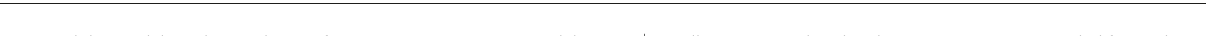
Fig. 3 DOT1L inhibition delays the incidence of GVHD in a xenogeneic model. a CD3 + T cells were stimulated with aAPC/mOKT3, expanded for 12 days in the presence of 0.5 μ M SGC0946 or DMSO, and subsequently infused into irradiated NSG mice (10 million T cells per mouse). b , c Relative body weight of the mouse compared to the weight prior to T-cell infusion. Sequential data at the indicated time points ( b ) and the body weight at day 14 ( c ) are shown ( n = 8 mice, unpaired two-sided t -test). d , e Kaplan – Meier analysis for more than 10% weight-loss-free survival ( d ) and overall survival ( e ) following T-cell transplantation ( n = 8 mice, log-rank test). The data shown are representative of three independent experiments. f Histological assessment of the indicated organs showing lymphocyte in fi ltration (hematoxylin and eosin staining) on day 21 following T-cell transplantation. Scale bar, 100 μ m. g Human CD4 + or CD8 + T-cell chimerism in the peripheral blood 14 days following T-cell transfer ( n = 8 mice, unpaired two-sided t -test). h – j Surface expression of CD45RA, CD62L and CCR7 was analyzed in the persistent T cells within the peripheral blood on day 14. Representative FACS plots ( h ) and frequency of CD45RA + CD62L + CCR7 + cells within the CD4 + or CD8 + T-cell population ( i ) or within the total peripheral blood mononuclear cell population ( j ) are shown ( n = 8 mice, unpaired two-sided t -test). NS, not signi fi cant. Horizontal lines represent the means ±